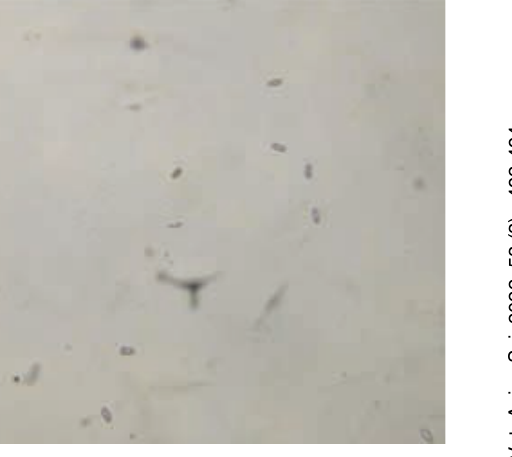
Fig. 4. Eggs of Spirocerca